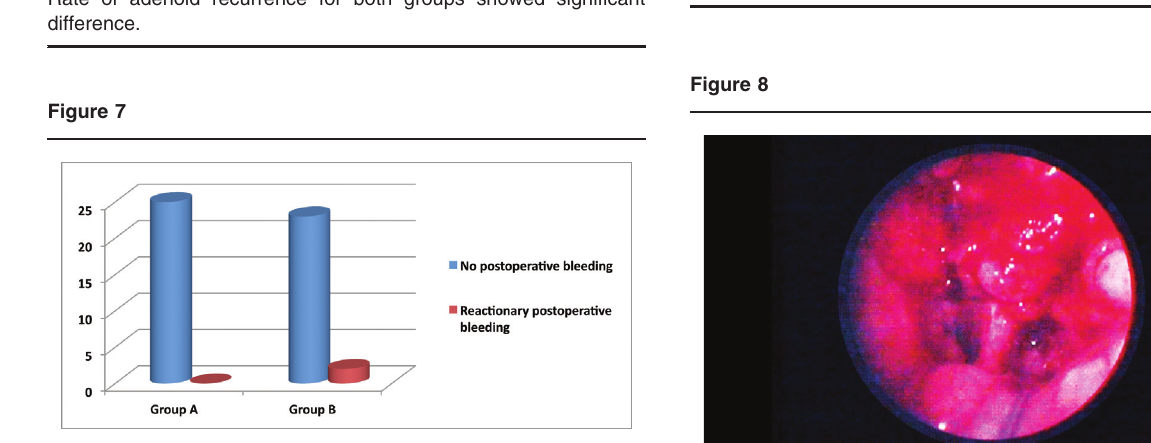
Comparison between the mean operative time for both groups.